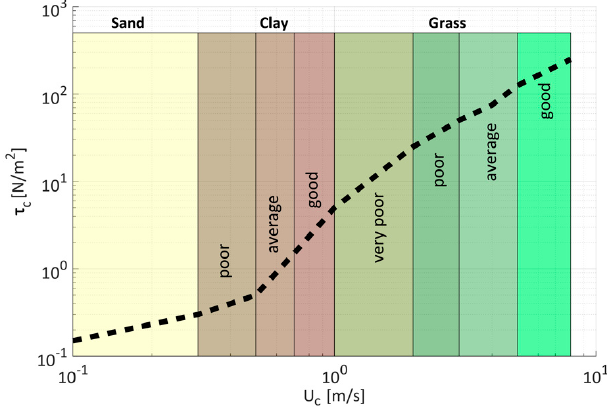
Figure 8. Equivalence curve between critical velocity, U c , and critical shear stress, τ c , built from values reported in [14]. This curve is used to include C E as a stochastic random variable by transforming the stochastic U c from Table 4 to τ c values, which is required as input for C E using Equation (9). The stochastic distributions for the U c of grass and soil, were taken from Ref. [21]. This work